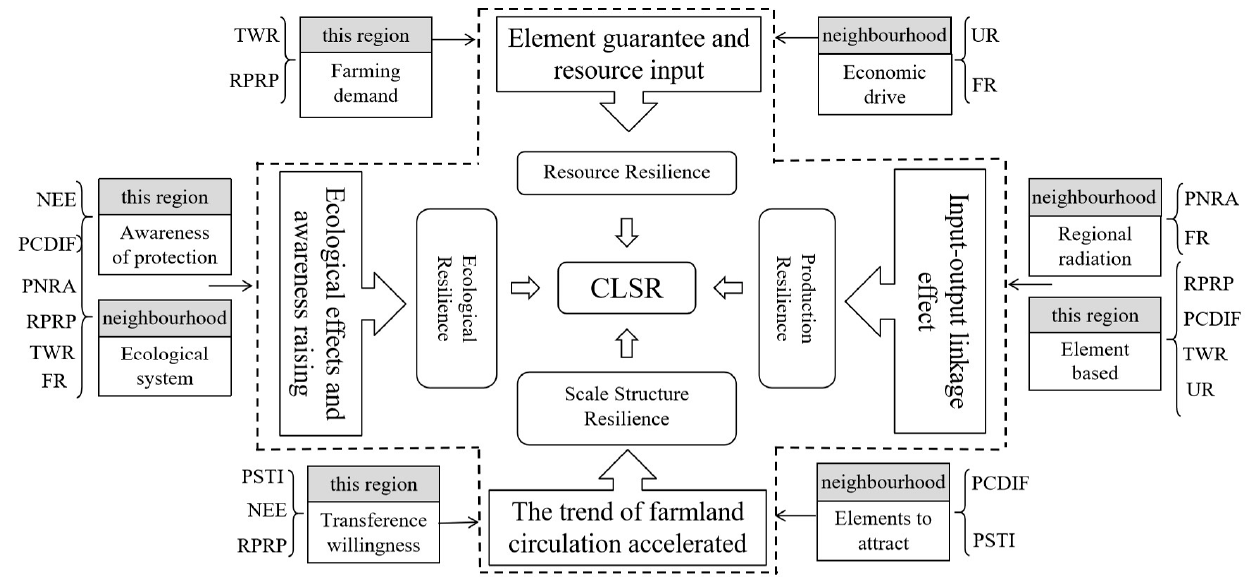
Figure 6. Cultivated Land Use System Resilience (CLSR) partition driver mechanism. Note: TWR: Total water resources, PNRA: The proportion of natural reserve area, NEE: Number of environmental emergencies, PCDIF: Per capita disposable income of farmers, UR: Urbanization rate, FR: Fiscal revenue, PSTI: The proportion of secondary and tertiary industries, RPRP: Rural permanent resident